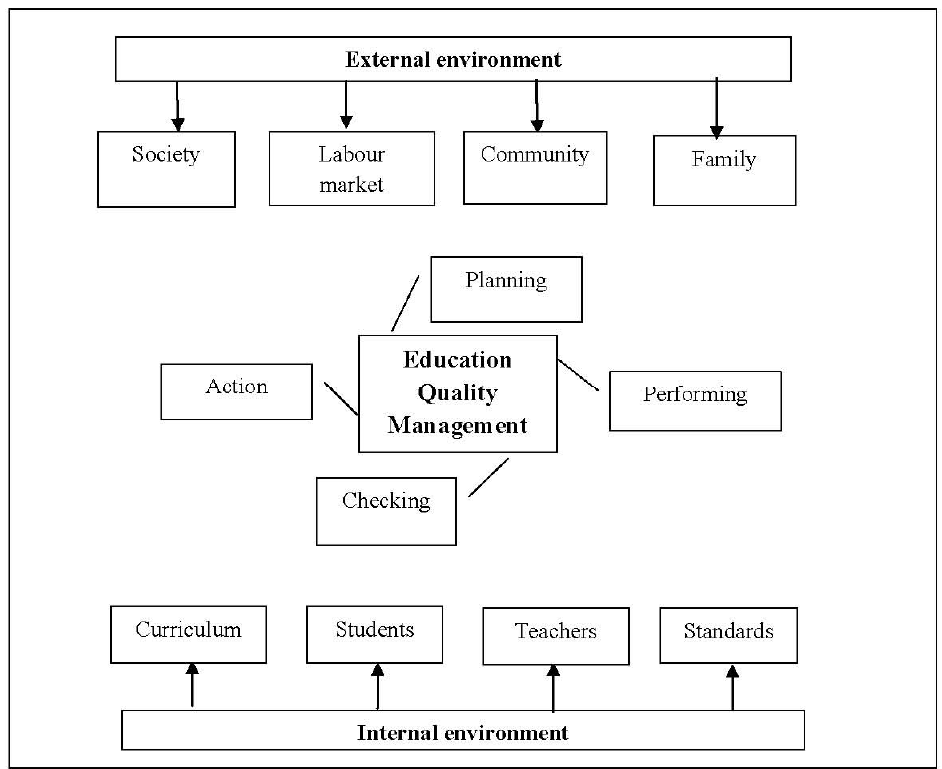
Figure 1. The integrated model of education quality management.